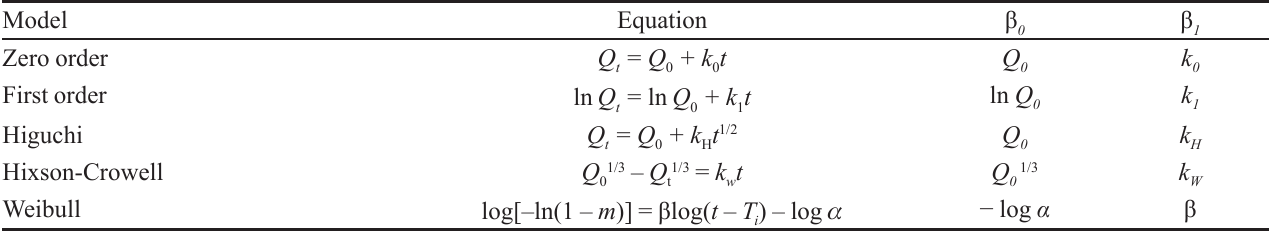
TABLE I - Regression models applied to dissolution profiles of MMF-IR and EC-MPS tablets